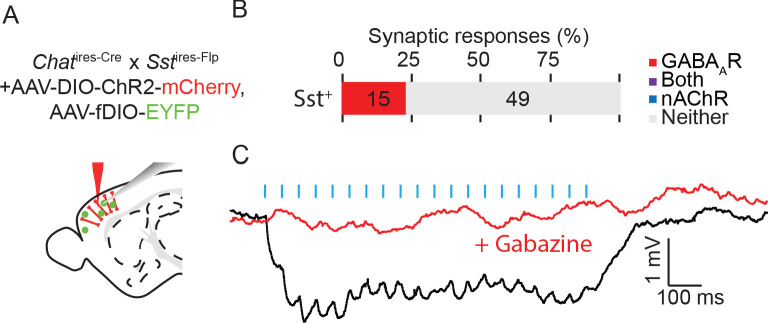
Cortical VIP+/ChAT+ neurons inhibit deep layer Sst+ interneurons.(A) Experimental design: Because the Sst-GFP (GIN) BAC transgenic mouse line does not express in deeper layer Sst+ interneurons, we targeted Sst+ interneurons in Layer 5 and Layer 6 by crossing Chatires-Cre mice with Sstires-flp mice and injecting with a AAV(8)-DIO-ChR2-mCherry and AAV(DJ)-fDIO-EYFP. After 3–4 weeks to allow expression of viral genes, whole-cell current clamp recordings were obtained from EYFP+ neurons in layers 5 and 6. Current clamp recordings were obtained with a potassium-based internal recording solution to enable detection of muscarinic ACh receptor-mediated currents. (B) Summary quantification of the proportion of cells showing synaptic responses following trains of optogenetic stimulation (3 ms pulses of 473 light, 20 × 20 Hz) of VIP+/ChAT+ interneurons. GABAergic responses were identified based on hyperpolarizing post-synaptic potentials and sensitivity to gabazine. The number of neurons in each category are indicated (n = 74 EYFP+ neurons from 8 Chatires-Cre x Sstires-Flp mice). (C) Example synaptic response to a train of optogenetic stimulation showing hyperpolarization that is blocked by gabazine.